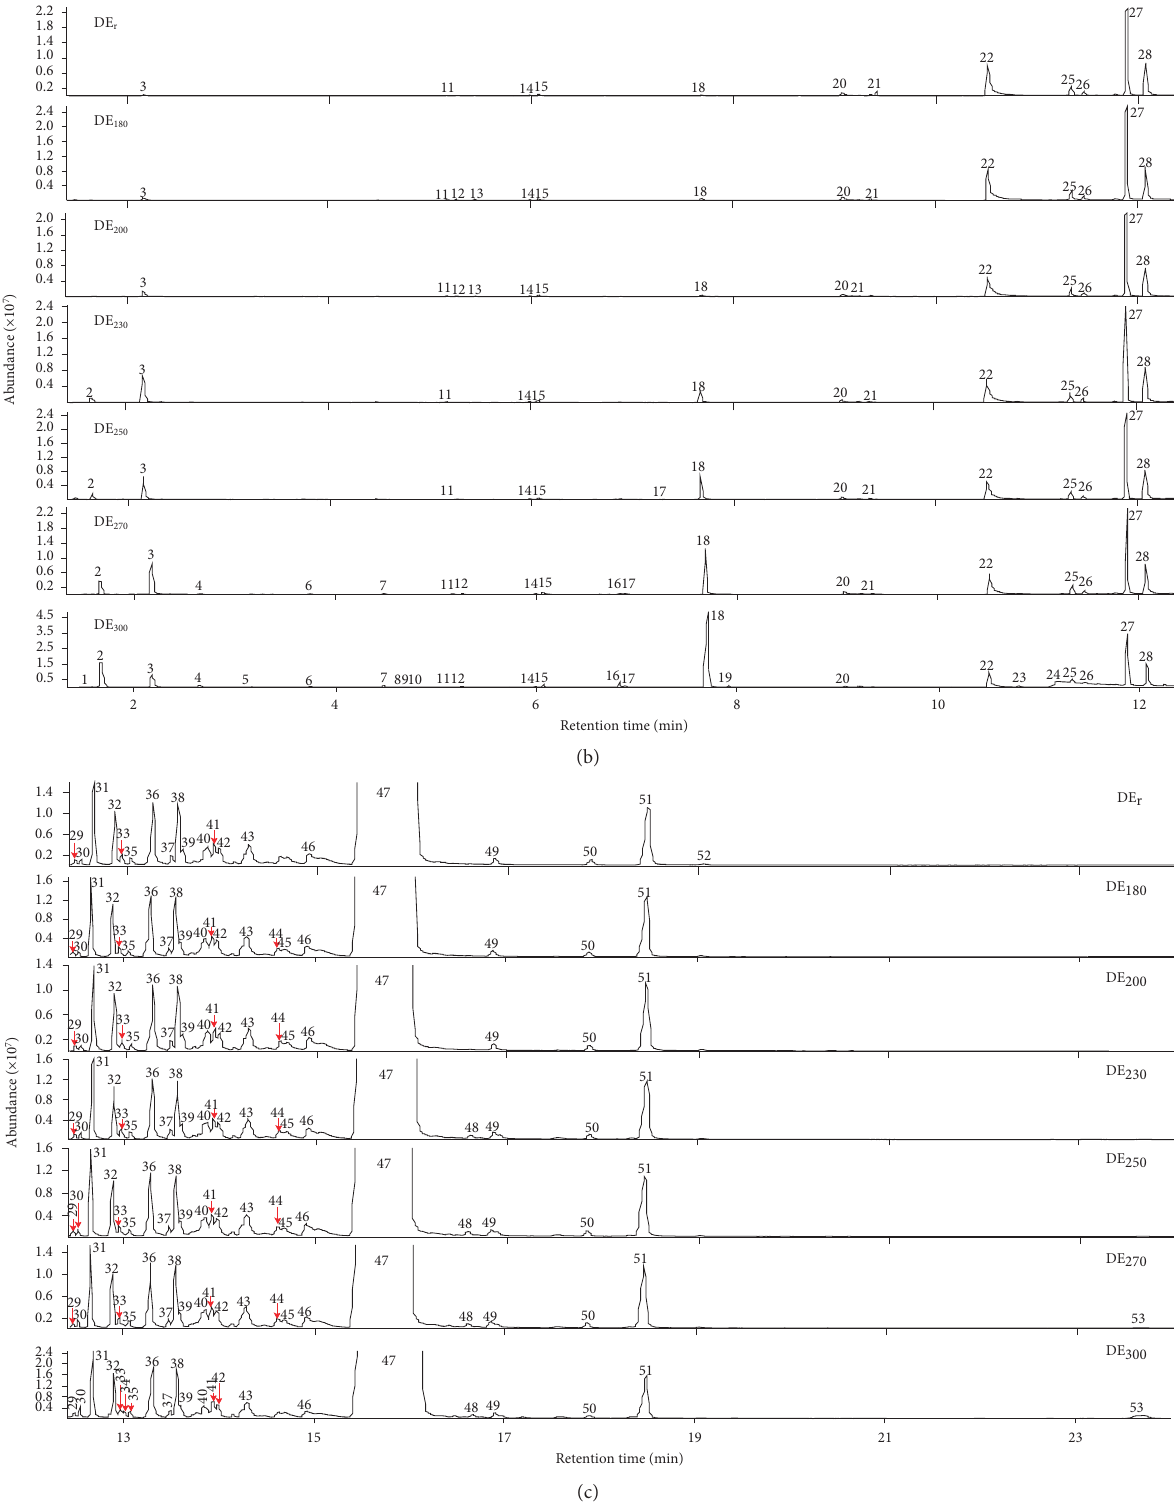
Figure 2: (a) Total ion chromatograms of oil samples after heating at different temperatures. (b) Total ion chromatograms of various oil samples over a retention time range of 1.4–12.4min. (c) Total ion chromatograms of oil samples over a retention time range of